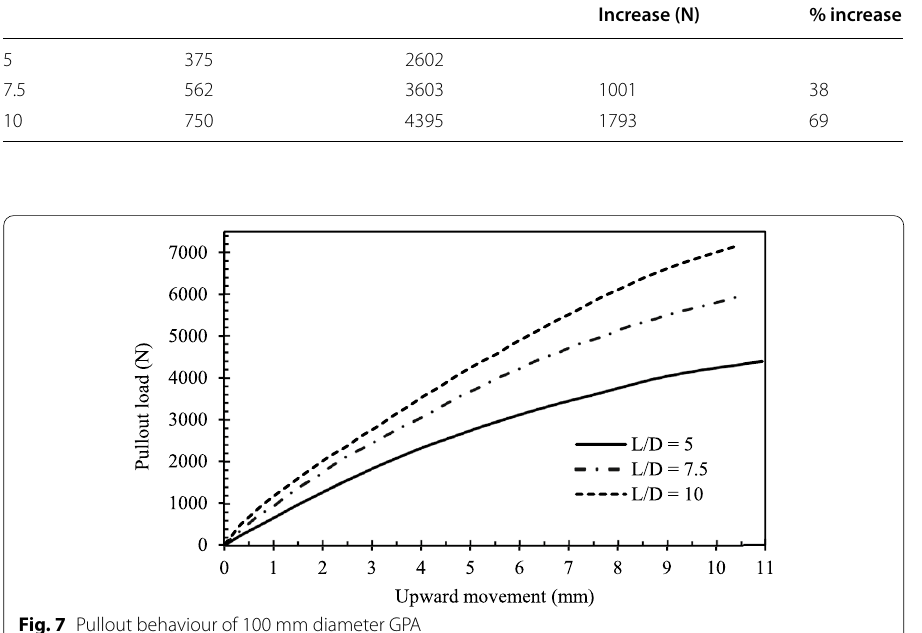
Fig. 7 Pullout behaviour of 100 mm diameter